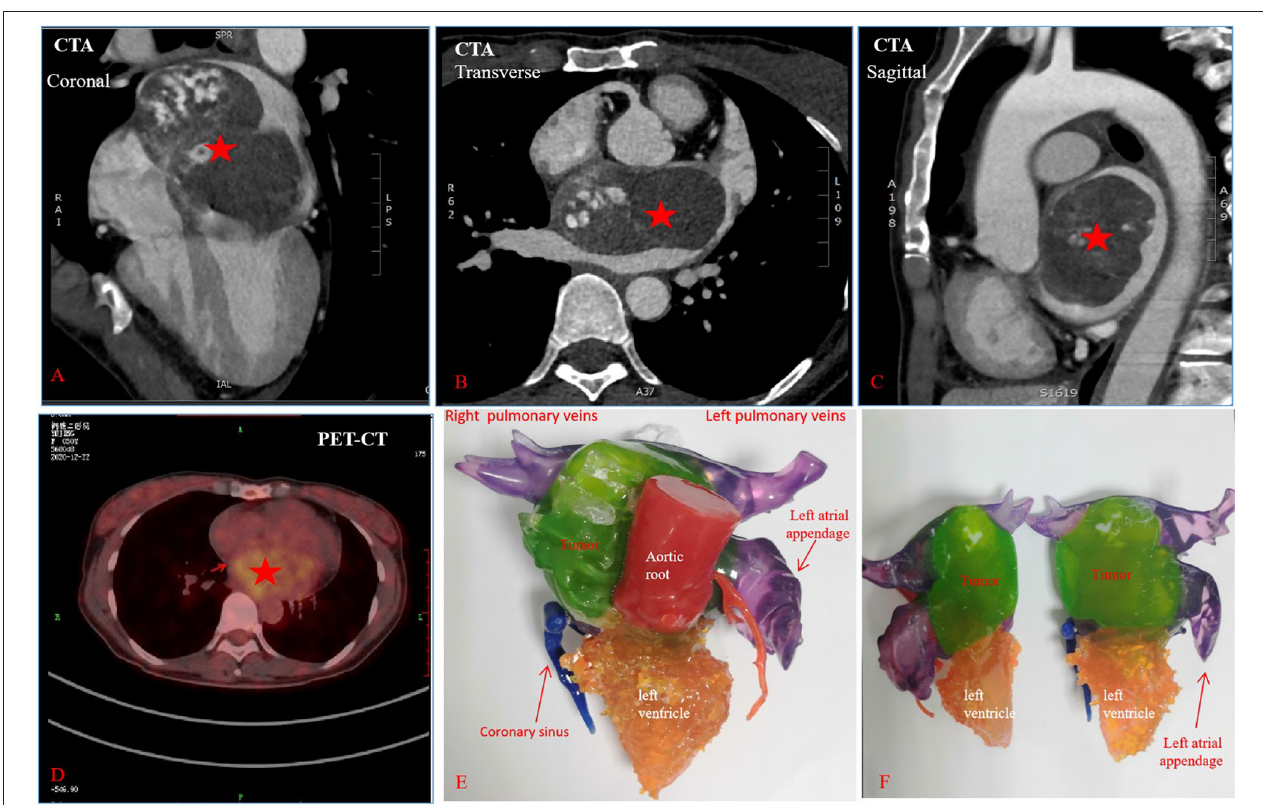
FIGURE 1 | Pre-operative images showing left giant atrial tumor and adjacent structures. (A–C) Indicate images from CTA, (D) indicates image from PET-CT, (E,F) indicate images from 3D printing model. Red asterisks indicate left atrial